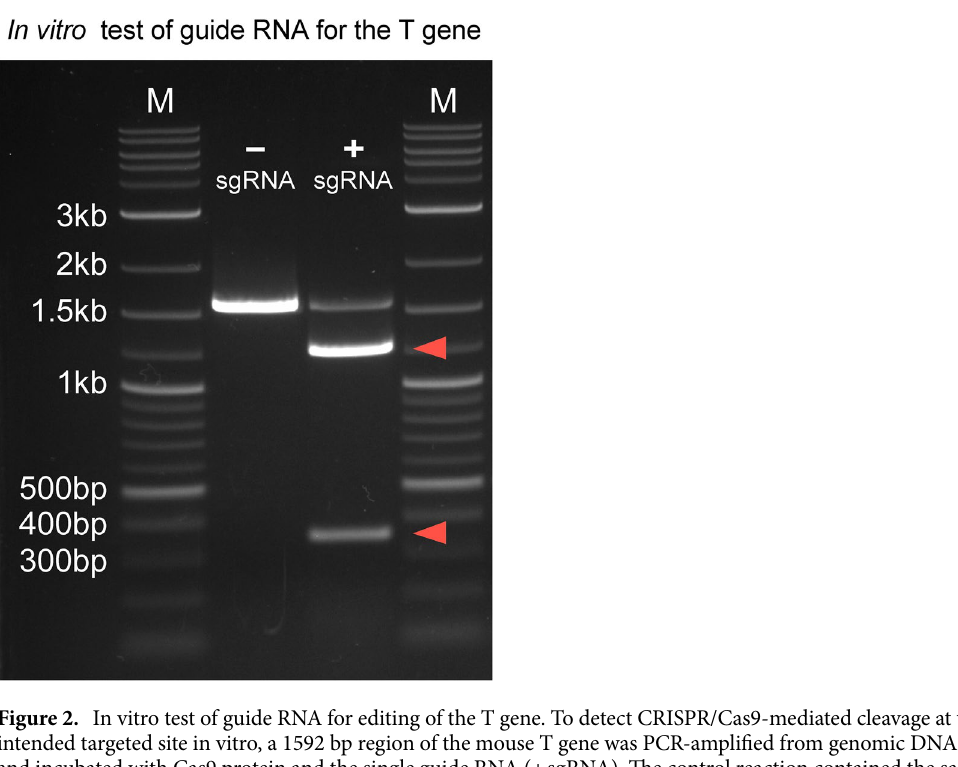
Figure 1. Transient transgenic strategy for CRISPR-induced mutagenesis. Schematic of the experimental approach: After microinjection of the Cas9/single-guideRNA ribonuclease complex into fertilized oocytes, the zygotes are transplanted into foster females. On gestational day E9.5, the morphology of individual F0 generation embryos is assessed, and the corresponding yolk sac tissue is collected for genotyping. This transient approach allows rapid screening of single, and potentially multiple, genes for developmental function without the need for breeding.